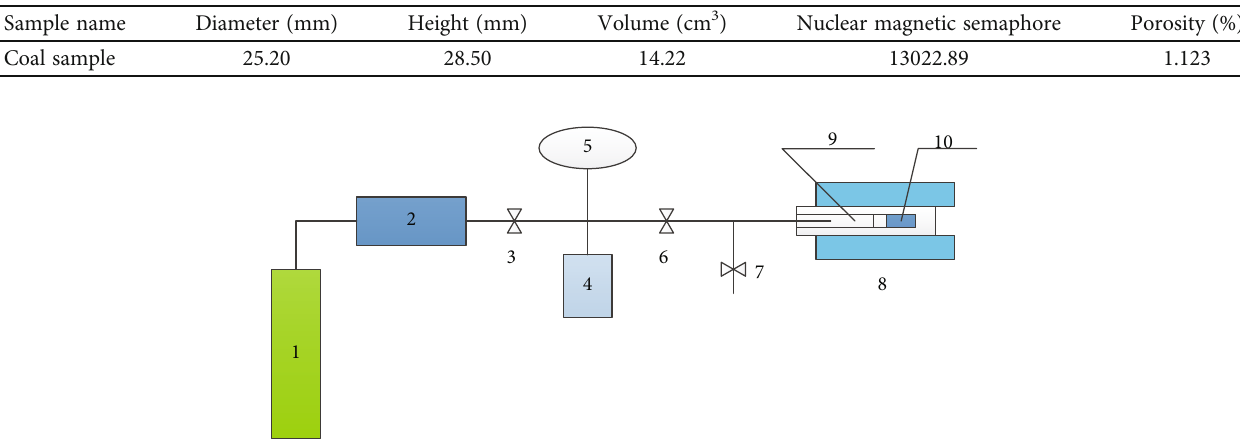
Figure 2: Schematic diagram of gas adsorption-desorption device. 1 — air source; 2 — pressure regulating valve; 3 — total gas switch; 4 — reference tank; 5 — electronic pressure gauge; 6 — balance switch; 7 — vent and pump-down switch; 8 — nuclear magnetic resonance instrument; 9 — clamp device; 10 —